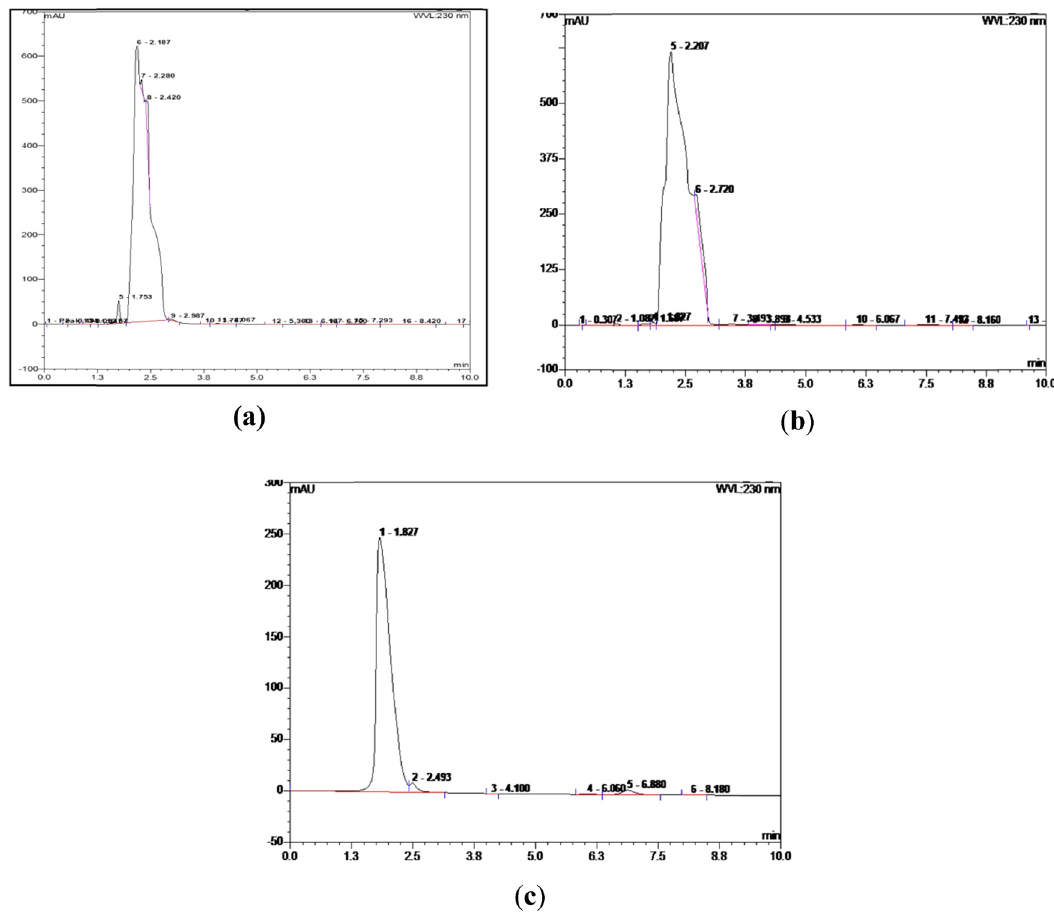
Figure 7: The chromatogram of blank serum ( a ) , serum spiked with DZP without MIP treatment ( b ) , and with MIP treatment ( c )